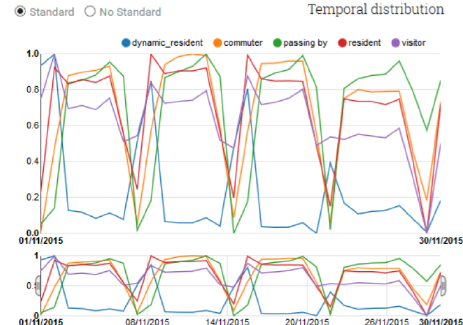
Figure 4. Temporal distribution. Example of a distribution of the presences in the analysed area based on the day of the month, stratified for user categories.